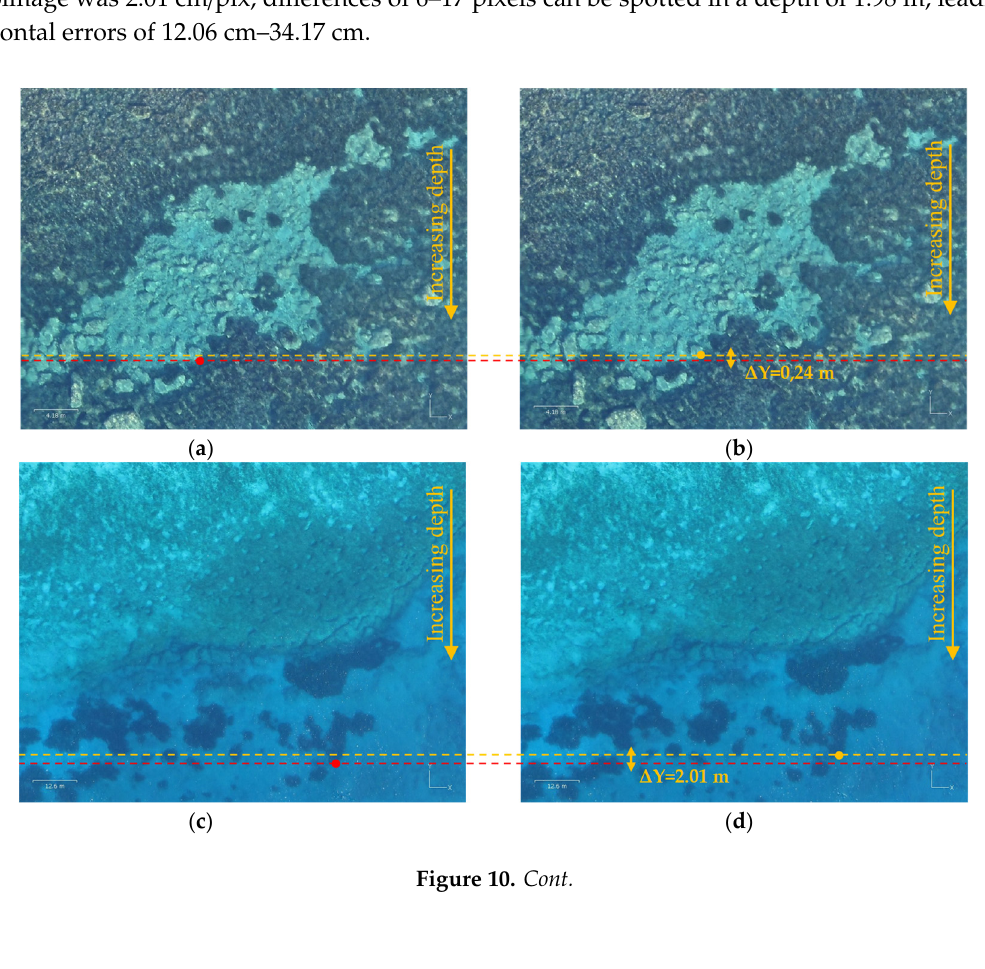
Figure 9. Indicative textured 3D models from Amathounta (first row), Agia Napa (second row), Cyclades-1 (third row), and Cyclades-2 (fourth row) test sites with the initial uncorrected (left column) and the refraction-free (right column)